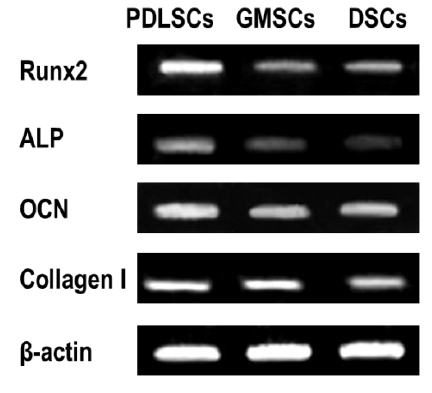
Figure 7. Expression of osteogenic genes including Runx2, ALP, OCN and collagen I by GMSCs, PDLSCs and DSCs (P3) after three weeks of osteogenic